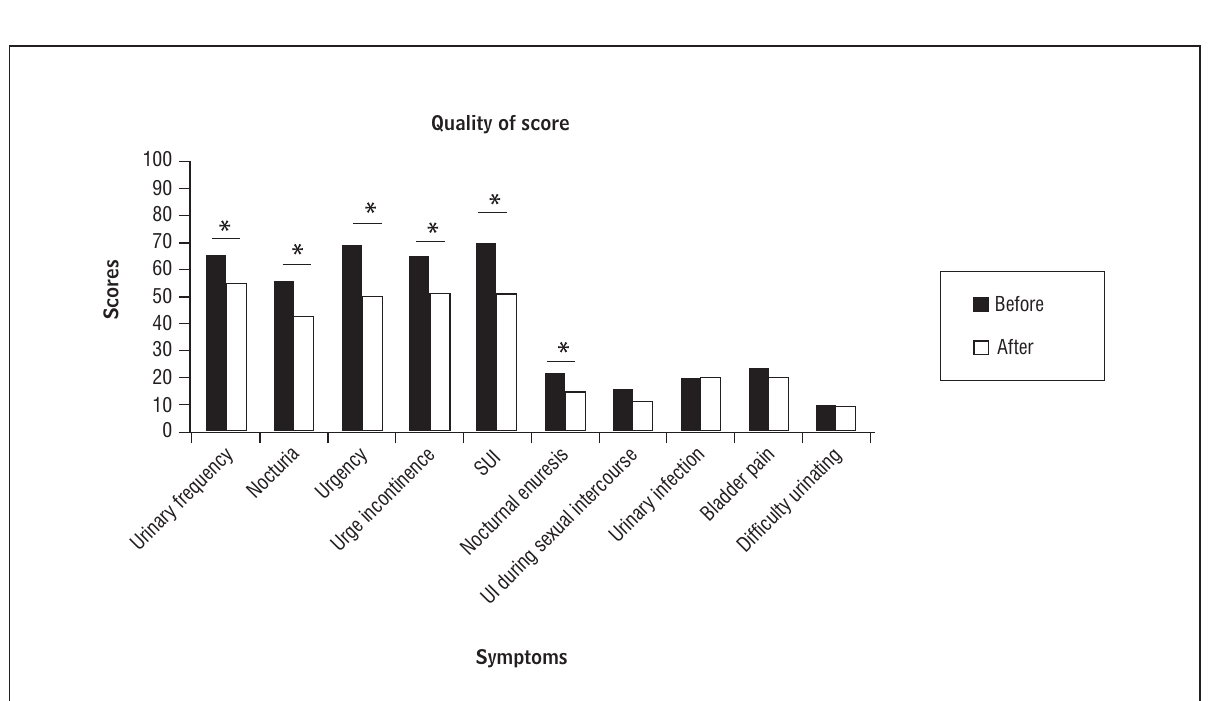
Figure 1 - Symptoms scores before and after guidance Source: Research data.